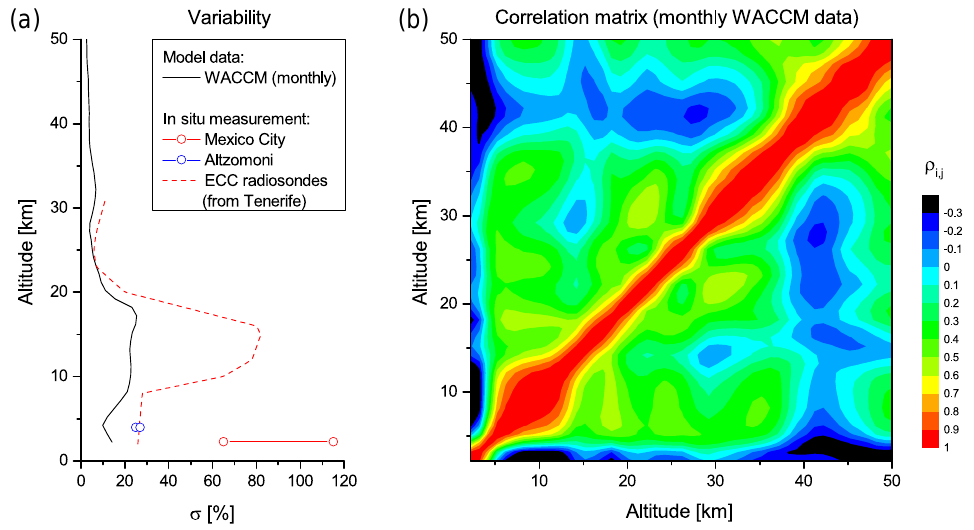
Figure B1. Atmospheric O 3 covariances ( S cov = (cid:54)(cid:48)(cid:54) T ) as obtained from models and measurements. (a) Diagonal elements of (cid:54) (1 σ variability), as obtained from WACCM (black line), ECC radiosondes in Tenerife (red dashed line) and surface in situ measurements in Altzomoni (blue circles) and Mexico City (red circles). (b) Correlation matrix (cid:48) as obtained from WACCM.